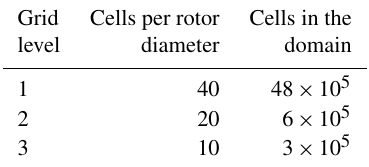
Table 3. Grid levels and size.